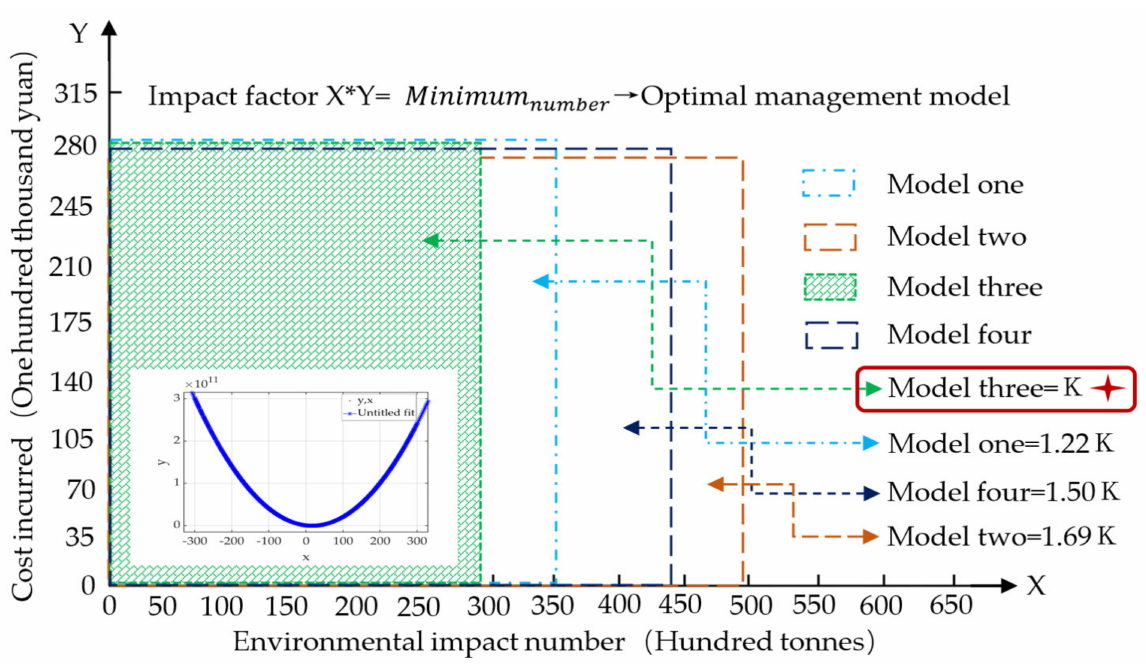
Figure 15. Comparison of the environmental impact and economic cost of the four options after comprehensive assessment (Figure x-y: Model 3 Interpolation analysis, the conclusion is that the mean is